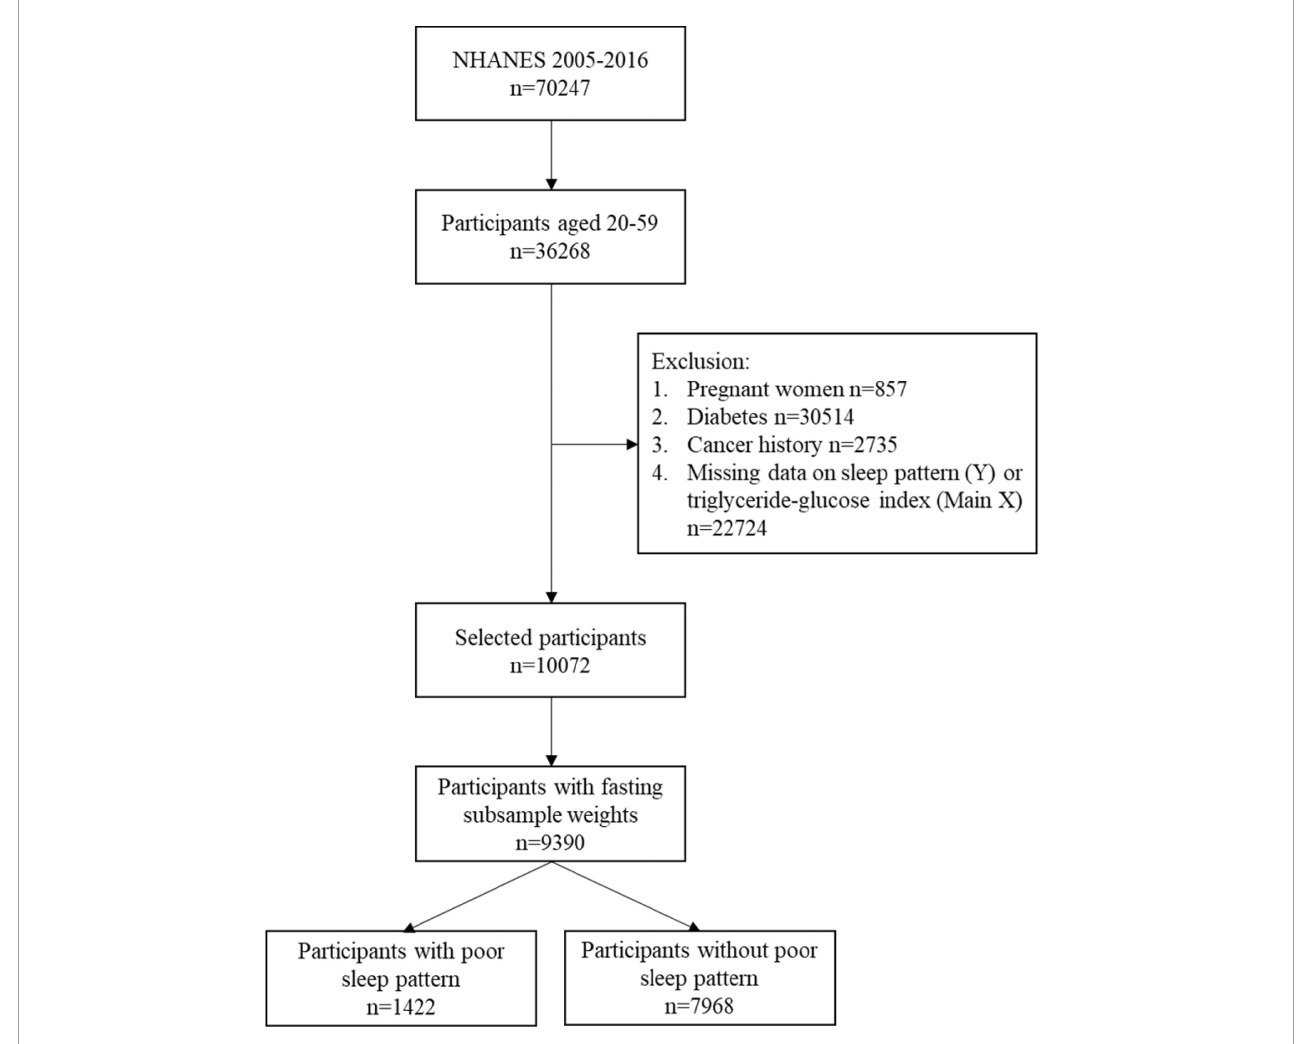
FIGURE1 Flow diagram of study population